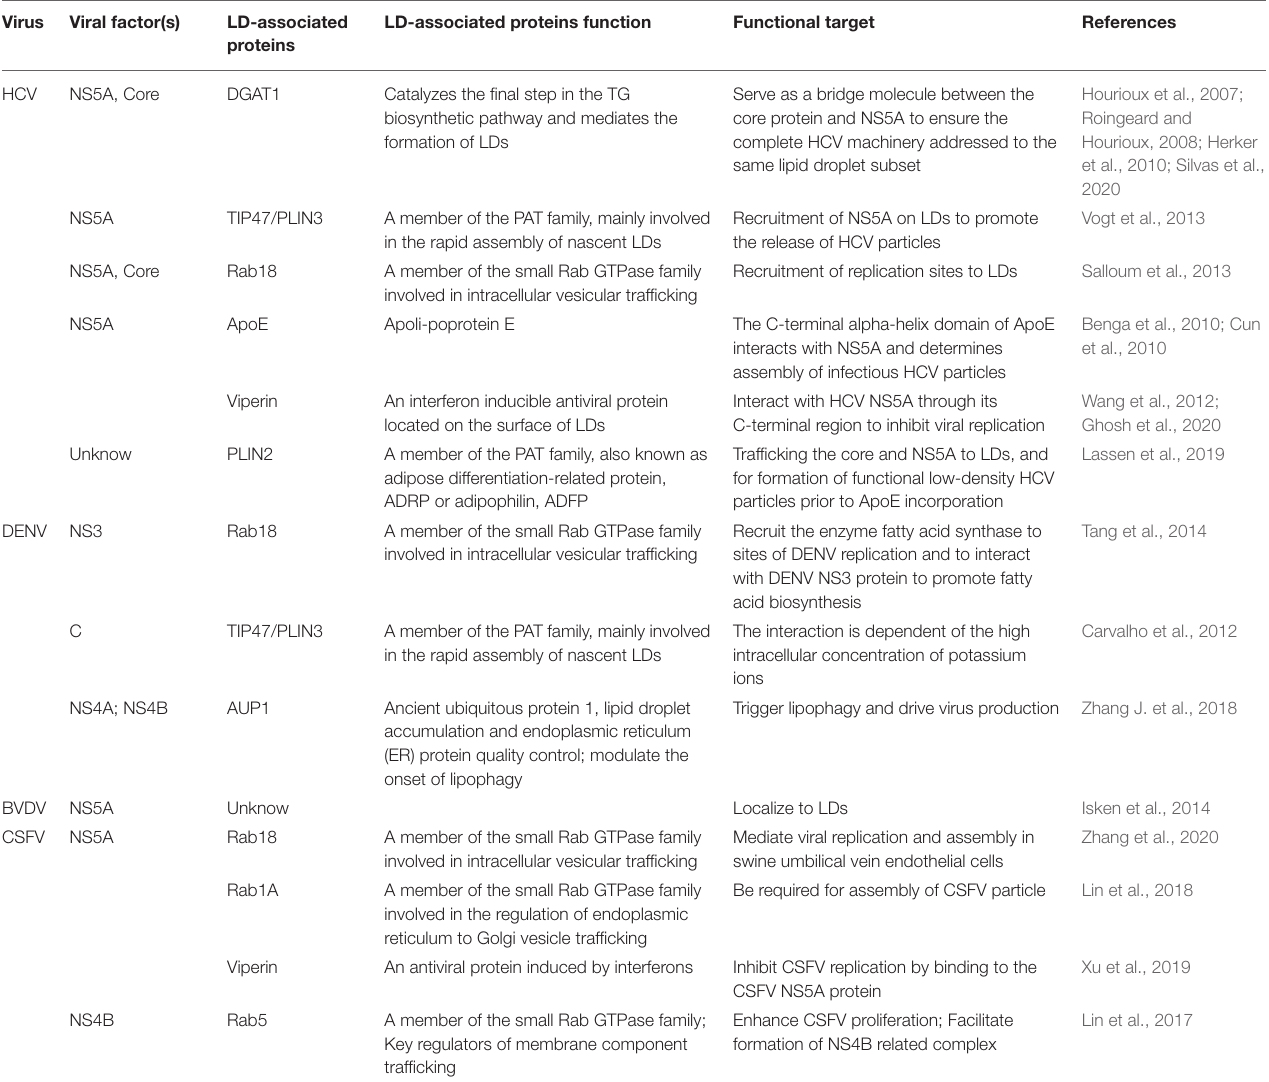
TABLE 1 | Summary of Flaviviridae -LD interactions.